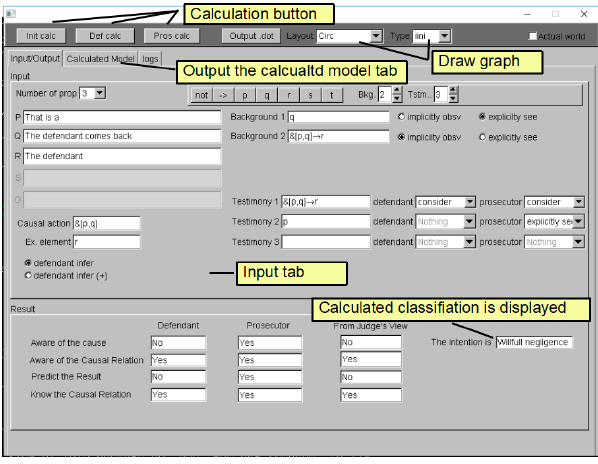
Fig. 2. Input/output